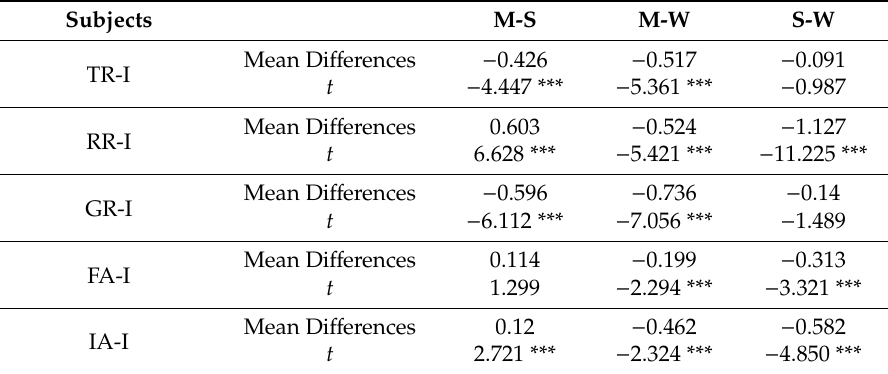
Table 2. The paired sample statistics for